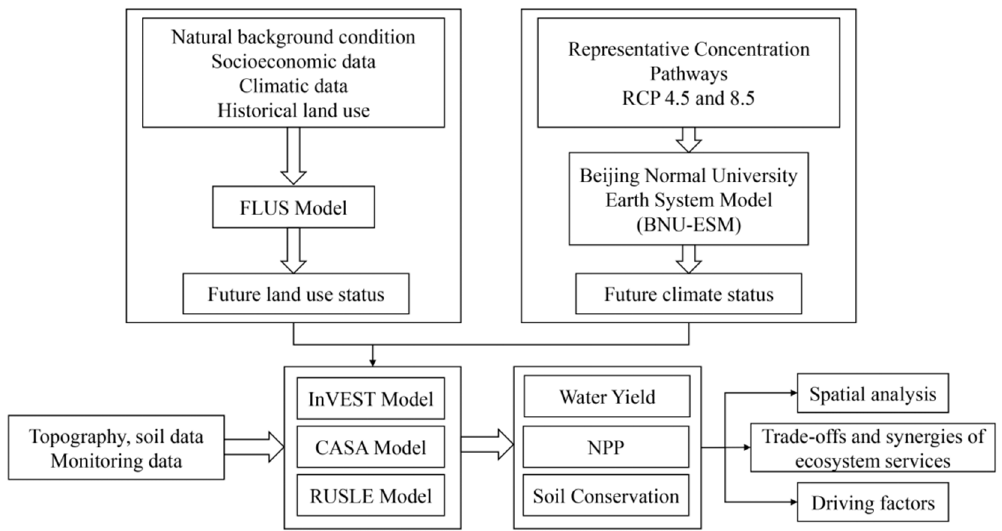
Figure 2. Framework for assessing trade-off and synergies among multiple ecosystem service responses to future climate change and land use change.